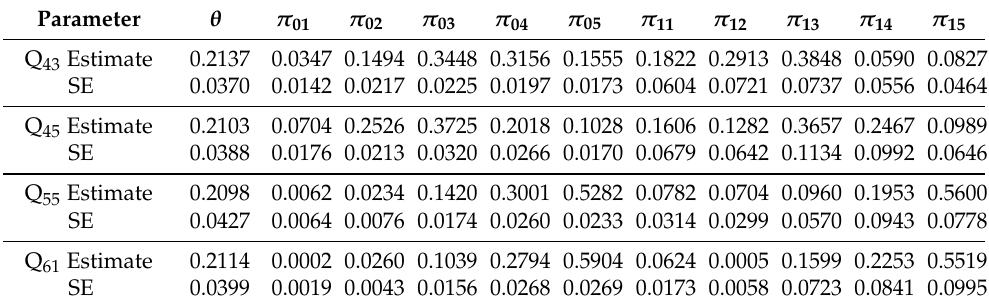
Table 2. (Results extracted from Table 1) Summary of significant results of the alternative/full model for the association between the sensitive characteristic variable from question 39: “Have you ever had a one-night stand through a dating site or mobile app?”, and each of the four observed ordinal categorical random variables for online dating experience corresponding to selected statements 43, 45, 55, and 61, respectively, by the likelihood ratio test at α =